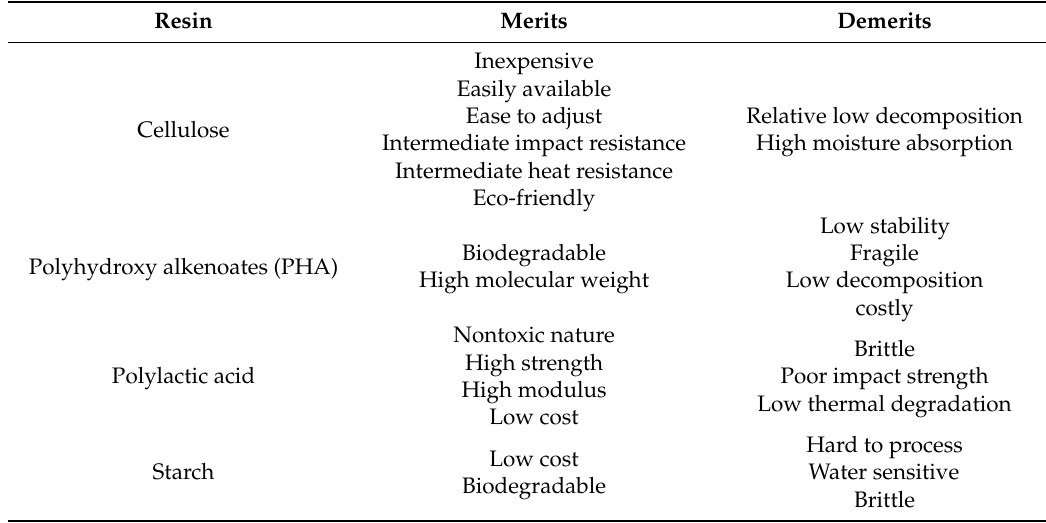
Table 13. Merits and demerits of bio-based